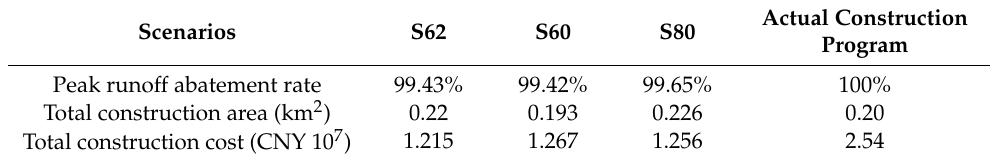
Figure 11. Similarity curves for 100 scenes by the variable weight-TOPSIS method. Table 5. Comparison of the optimal